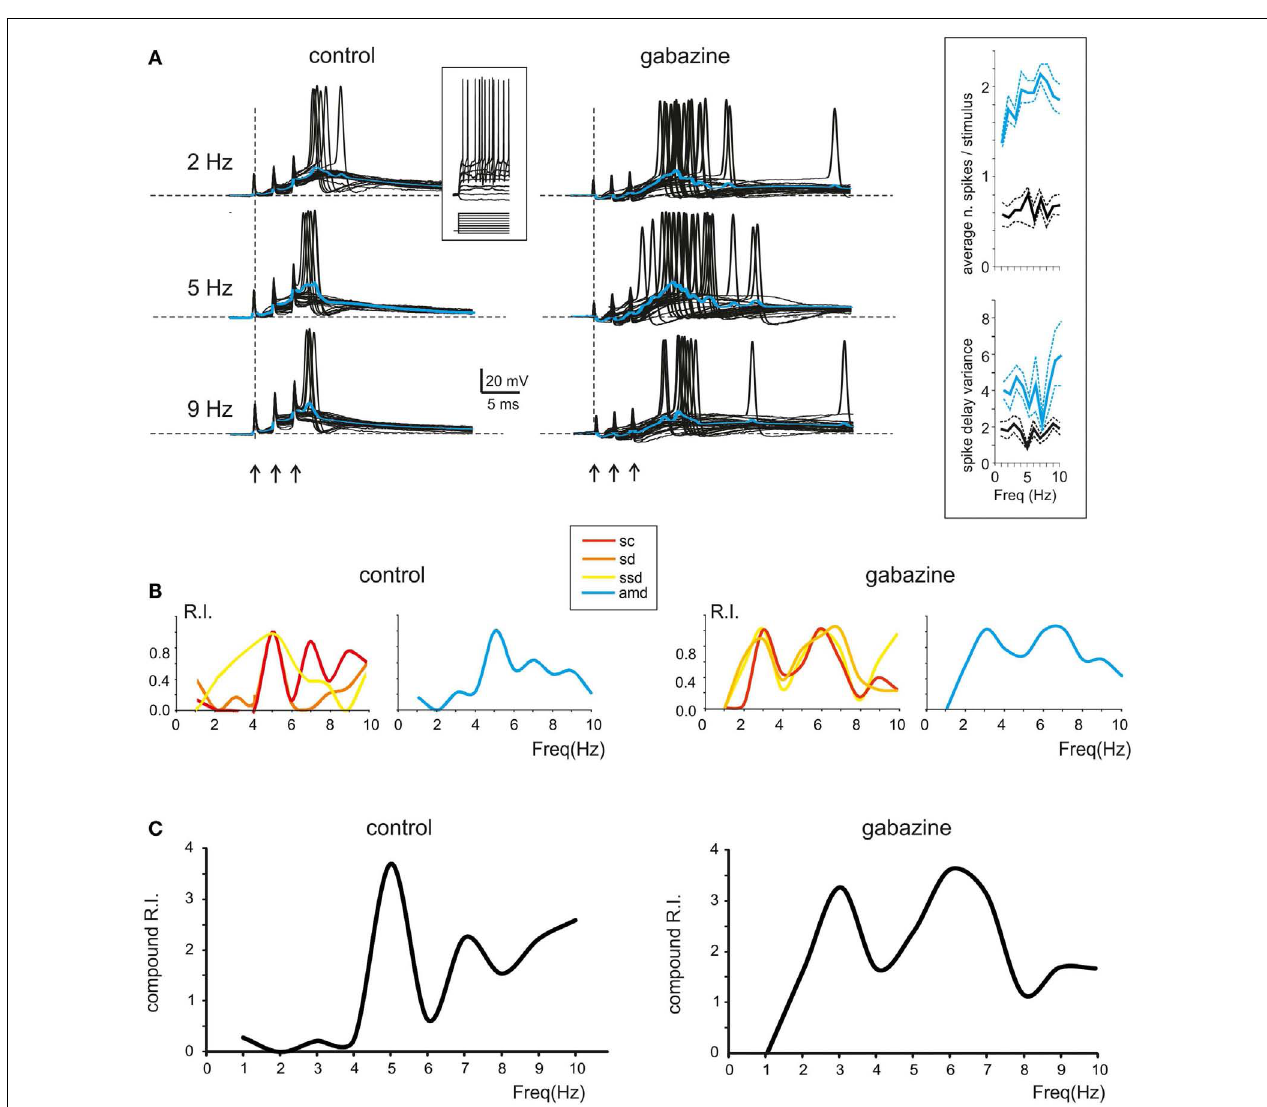
Blue traces show the average depolarization. Note that maximum depolarization is obtained at 5Hz.The inset in the middle shows granule cell responses elicited by 150ms-2pA current steps.The inset on the right shows the spike count and the spike variance in control and after gabazine perfusion. (B) Left ; In a single granule cell, the Resonance Index (RI) for individual parameters in control ( sc, ssd, sd, amd ) reveal peaks between 5 and 7Hz. Right ; In the presence of gabazine RI reveal peaks between 5 and 7Hz (C) Compound RI in the same granule cell in control ( left ) and in the presence of gabazine ( right